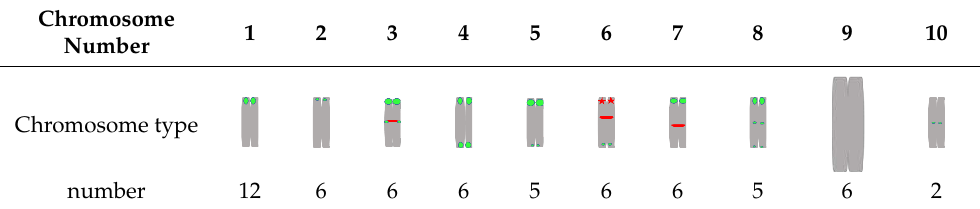
Figure 6. Chromosome karyotype of Hainan 92–105. Scale bars = 5 μm. Table 1. The different types of chromosomes based on repetitive sequence probes.